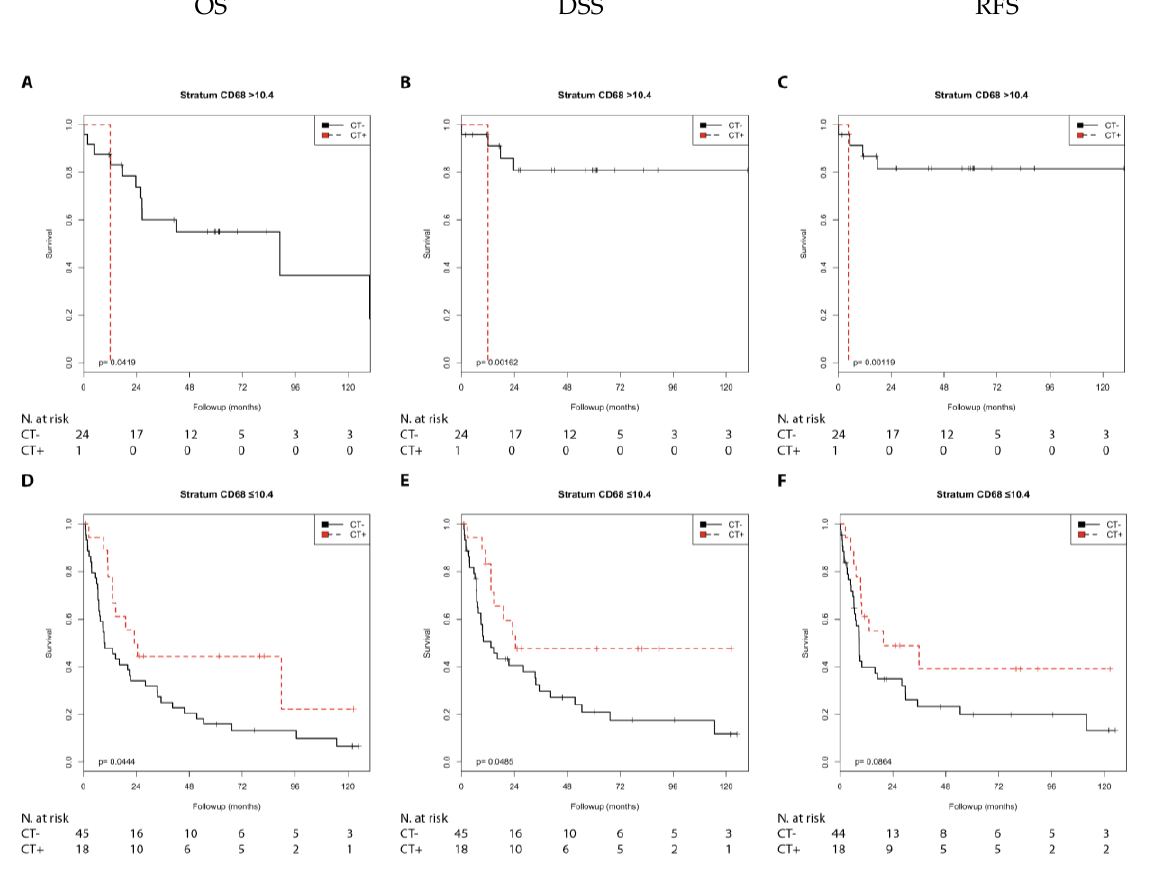
Figure 6. Kaplan–Meier analysis: Association of chemotherapy with prognosis (OS, DSS, and RFS) in the pT2/pT3 + 4 groups stratified by CD68 expression (>10.4 or ≤ 10.4). In the pT2 group ( A – C ) with CD68 (>10.4), chemotherapy was associated with shorter OS ( A ; p = 0.042), shorter DSS ( B ; p = 0.002), and shorter RFS ( C ; p = 0.001). In the pT3 + 4 group ( D – F ) at CD68 ( ≤ 10.4), chemotherapy was associated with longer OS ( D ; p = 0.044), longer DSS ( E ; p = 0.048), and as trend with longer RFS ( F ; p = 0.086).